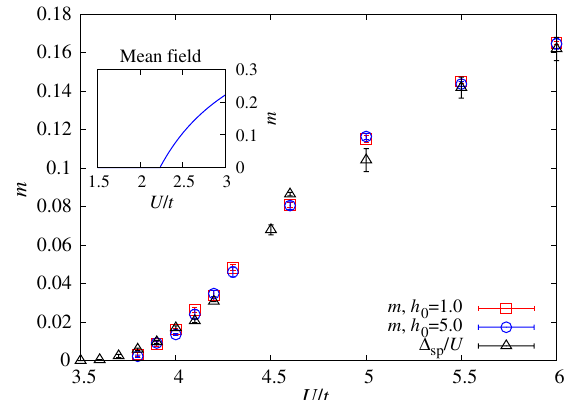
FIG. 4. Staggered moment extrapolated to the thermodynamic limit (see Fig. 3) for two values of the pinning field. We have equally plotted the single-particle gap in units of U . The inset plots the staggered magnetization as obtained from a mean-field spin-density-wave